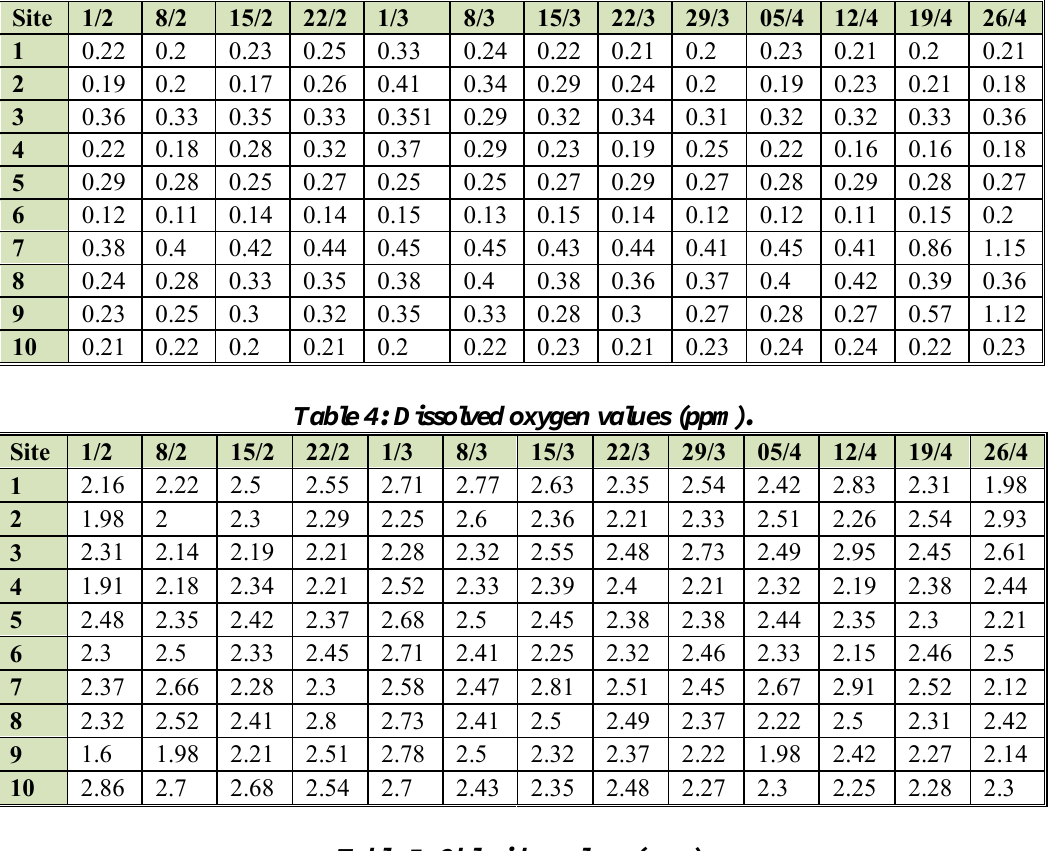
Table 3: Turbidity values in Nephelometric Turbidity Unit (NTU).